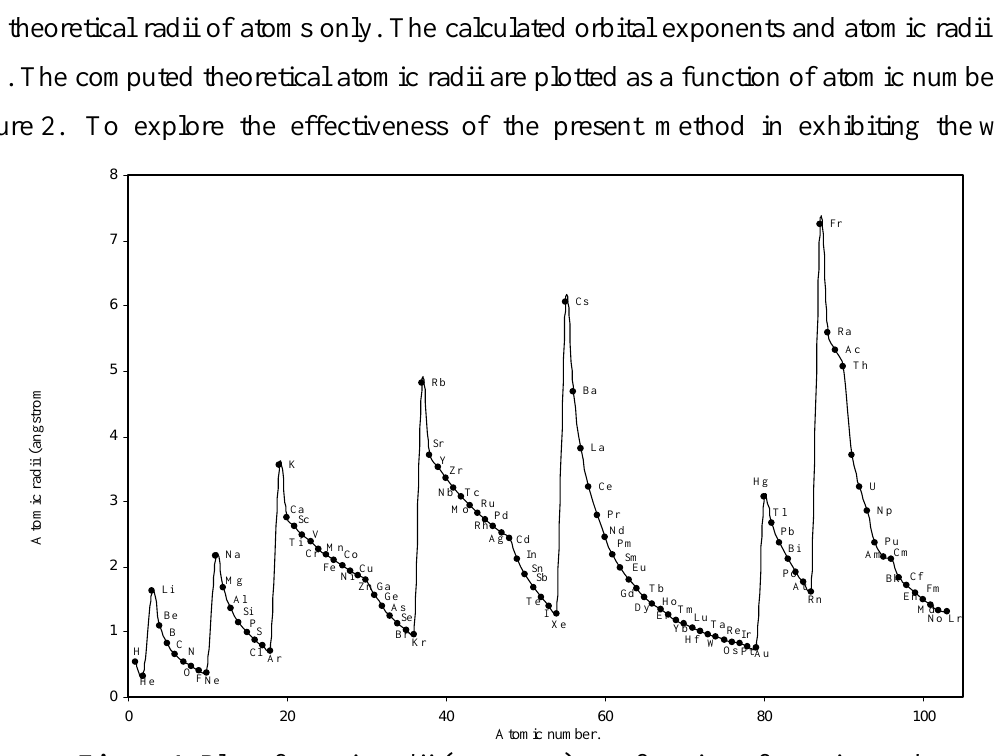
Figure 1. Plot of atomic radii (angstrom) as a function of atomic number.